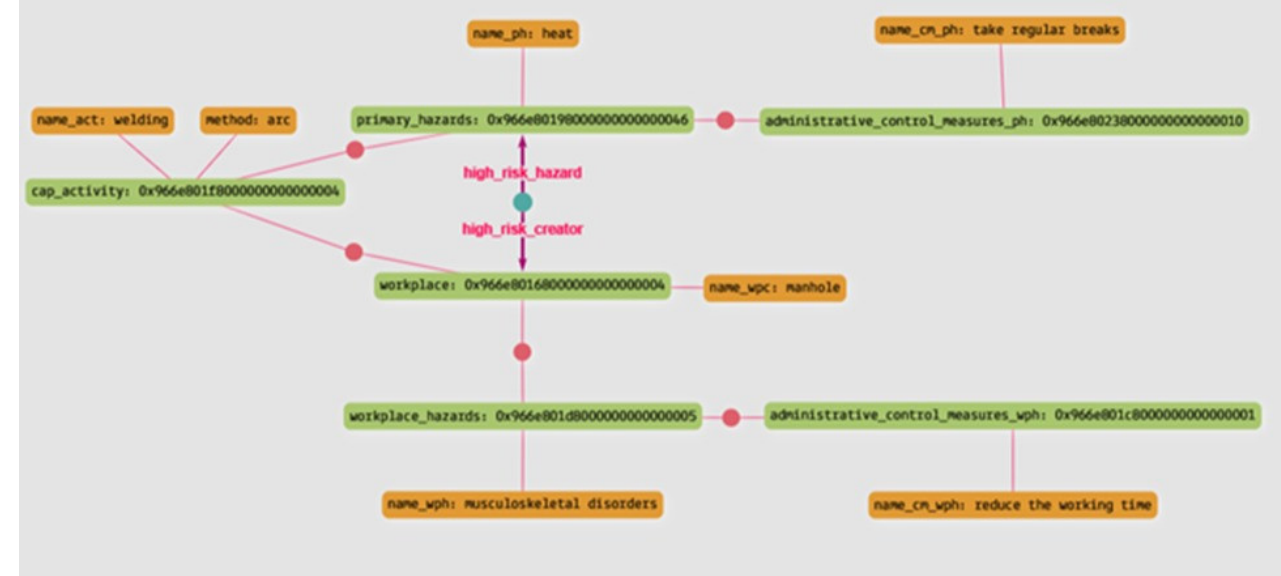
Figure 13. The result of Query 4, in a graph form. Table 8. The result of Query 4, in a tabular form.